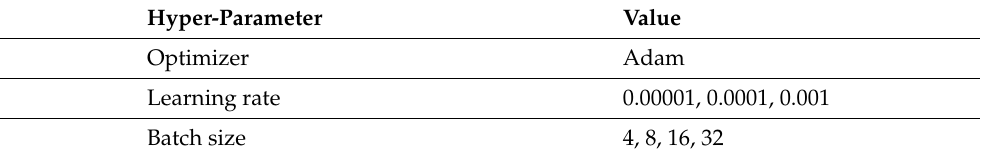
Table 2. Variable hyper-parameters and their values.